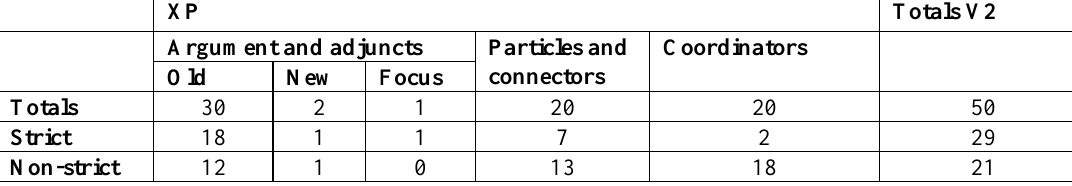
Table 2. Informational value of XPs in Year Book